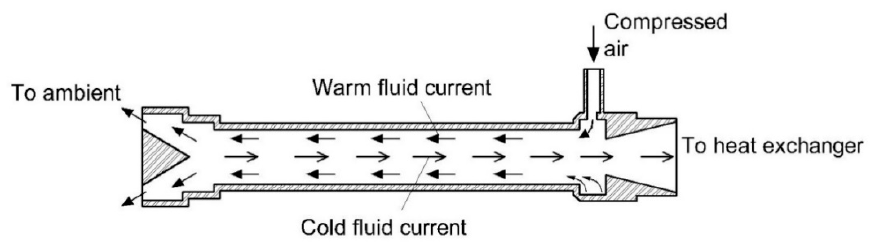
Figure 3. Fundamental flow diagram of a vortex tube [67].